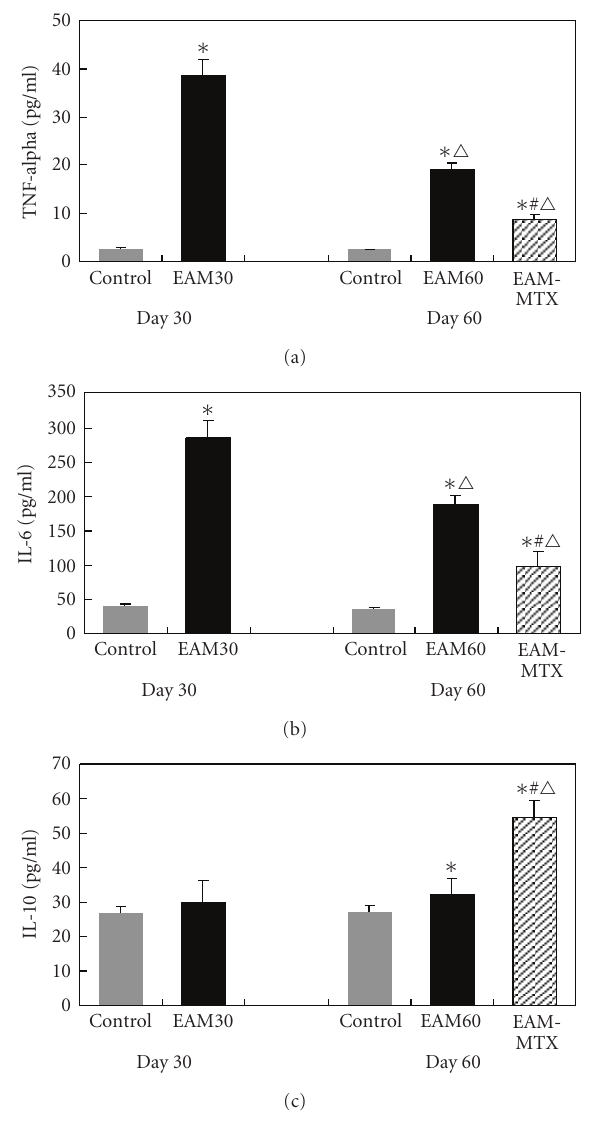
Figure 1: Changes of plasma cytokines levels. The levels of TNF- alpha, IL-6, and IL-10 were determined by ELISA. All results are expressed as mean ± SD ( n = 10). ∗ P < . 01 versus control group; (cid:2) P < . 01 versus EAM30 group. # P < . 01 versus EAM60 group;